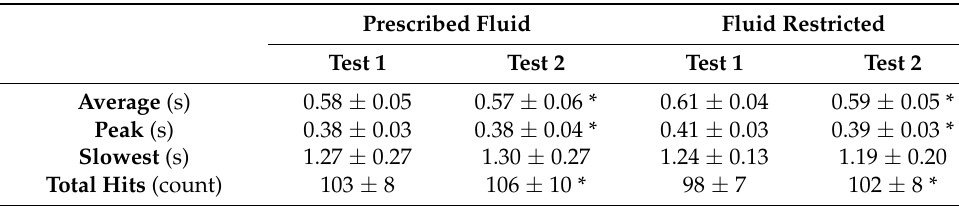
Table 1. Central visuomotor reaction time tests. Data are presented as mean (m) ± standard devia- tion (sd).